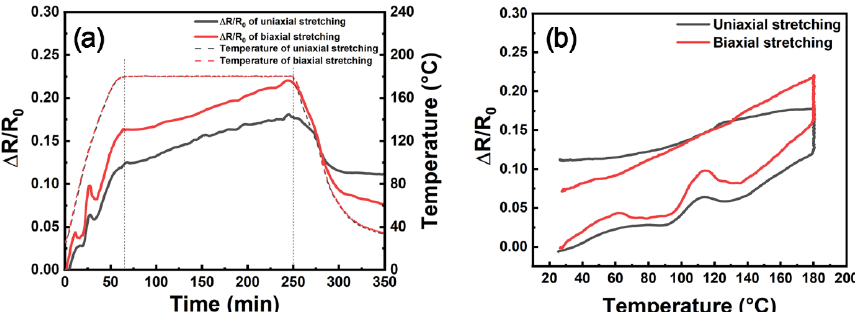
Figure 4. The electrical resistance variation with ( a ) time and ( b ) temperature for stretched samples.